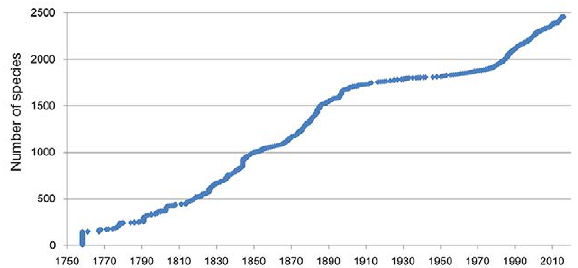
Fig. 4. – Cumulative number of species (“Present” and “Revisable”) present in Spanish waters, plotted against their year of first descrip- tion. Note the steeper slope in the late 19th century and from 1980 to the present, and the low rate of new descriptions in the first 3/4 of the 20th